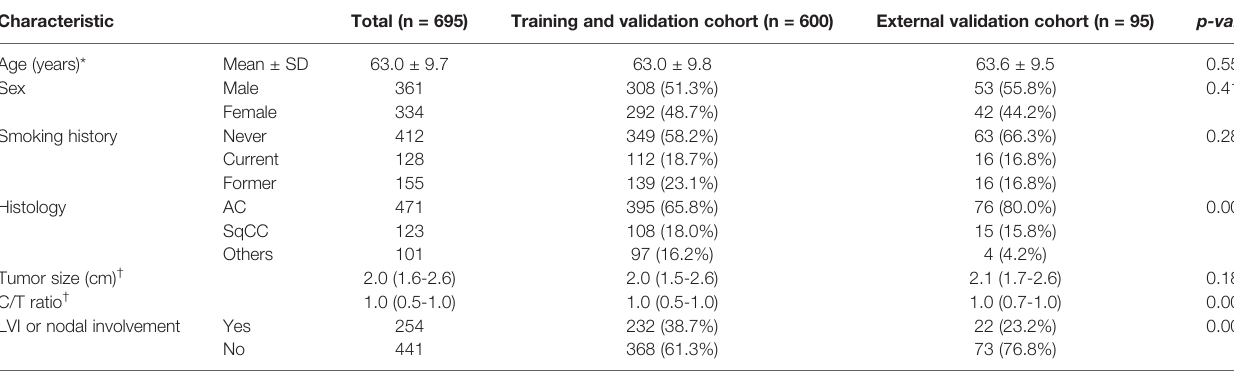
TABLE 1 | Baseline characteristics of the training, validation, and external validation cohorts.